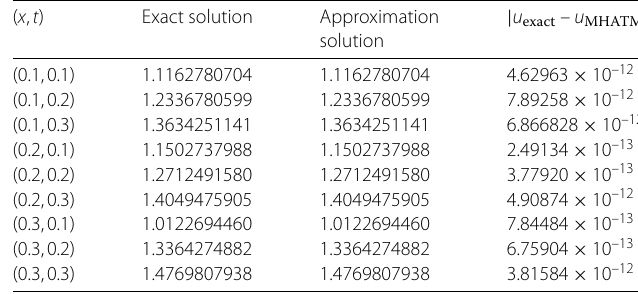
Table 5 E 7 in the solution of TFCRDEs by HATM for λ = 1 ( x , t )